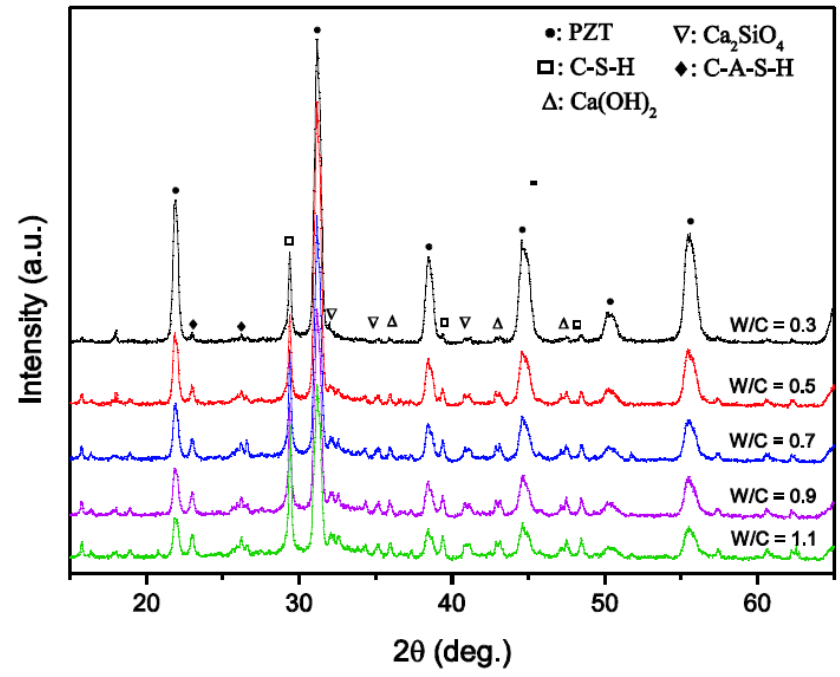
Figure 2. XRD patterns of PZT – PC composites with different water/cement ratios.